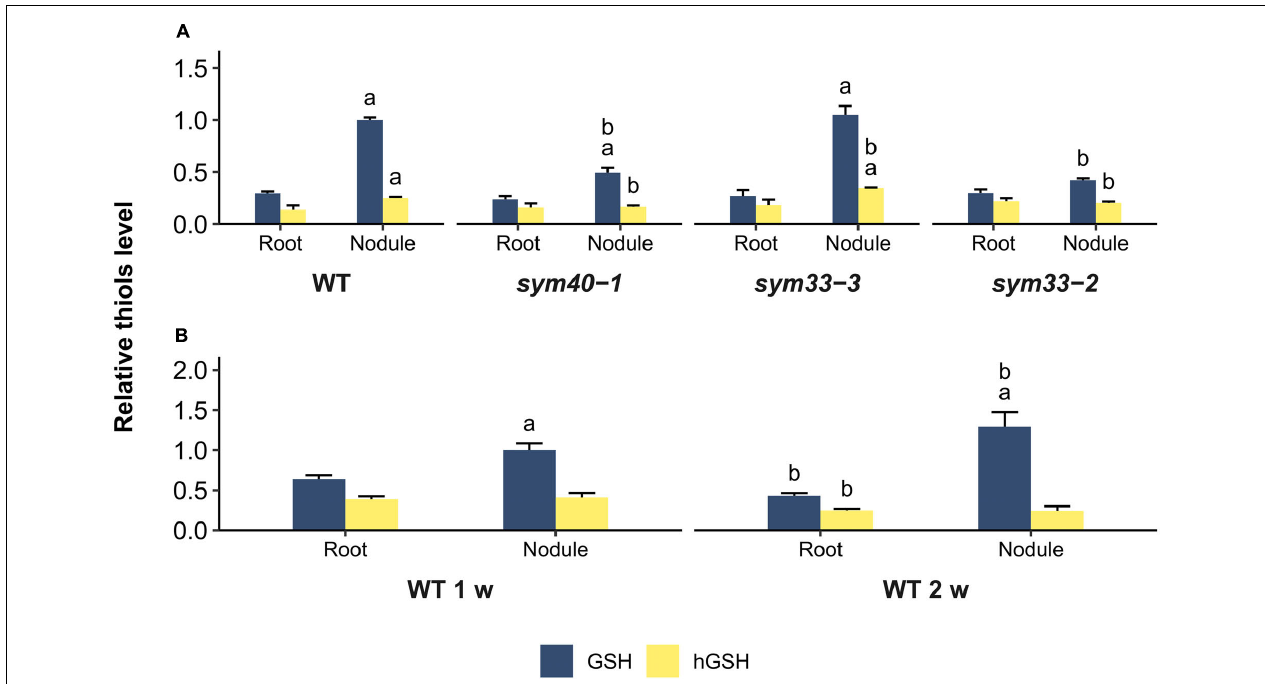
FIGURE 6 | Relative thiol levels in nodules and roots of wild-type and mutant ( sym40-1 , sym33-3 , and sym33-2 ) pea ( Pisum sativum ) plants. (A) Three-week-old uninoculated roots and nodules. (B) One- and two-week-old uninoculated roots and nodules. The values are given relative to glutathione content in (A) 3-week-old wild-type nodules and (B) 1-week-old wild-type nodules. GSH/hGSH amount in the samples were normalized relative to the GSH amount in 1- or 3-week-old wild-type nodules. The amount of thiols in nmol/g presented in Supplementary Table 2 . The graphs show the results of four independent experiments. Lowercase letters indicate significant differences (two-way ANOVA, P < 0.05) in content of each thiol for different groups as follows: (A) a, effect of the inoculation for each genotype; b, effect of the genotype (each genotype was compared to the wild type); (B) a, effect of the inoculation for each time point; b, effect of the age for roots and